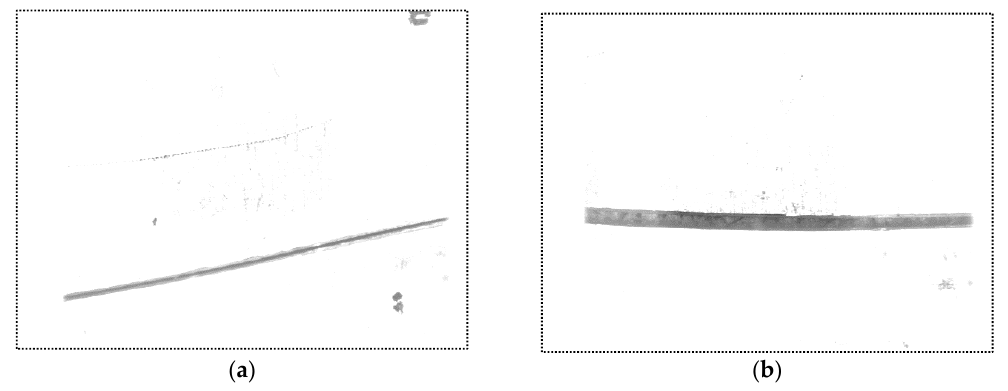
Figure 30. The narrow butt images captured during welding. ( a ) The image captured at the earlier time; ( b ) The image captured at the later time.